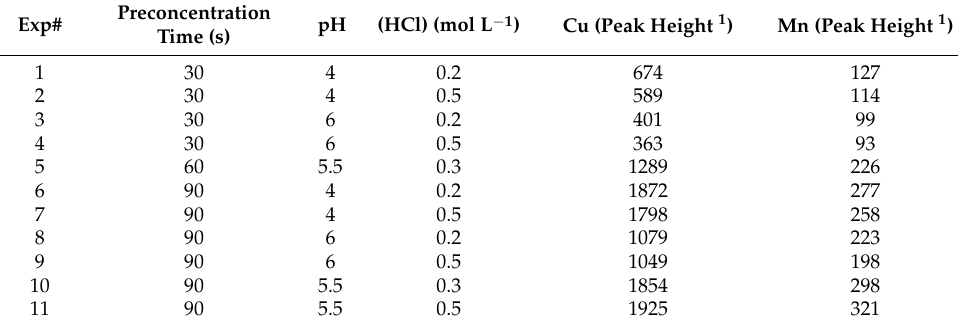
Table 2. Central composite design (3-level, 3